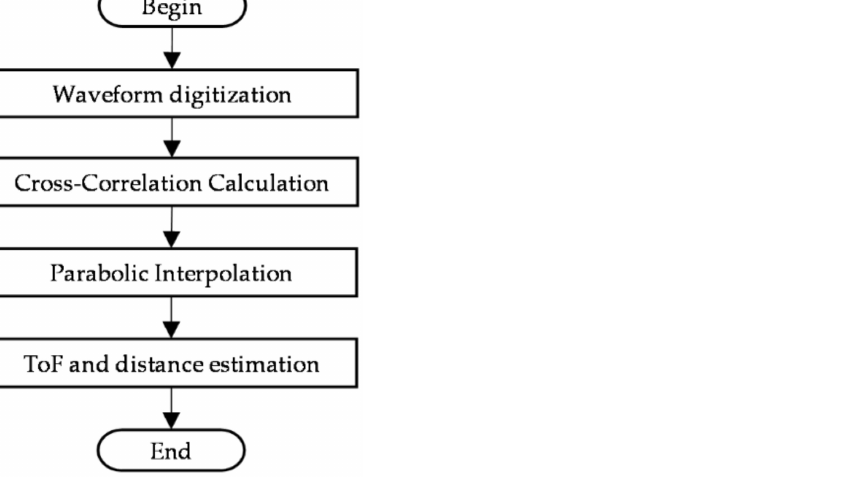
Figure 12. Procedure for determining ToF and distance by CC method combined with parabolic interpolation